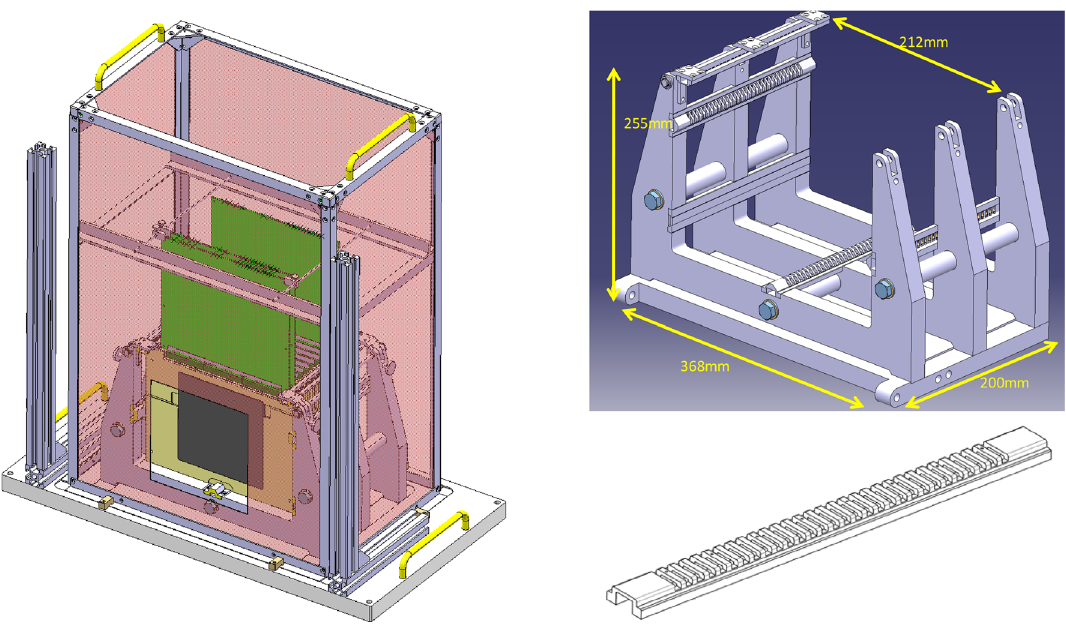
Fig. 2 Left-hand side: Scheme of the complete mechanical structure with the tungsten absorbers and readout boards installed. Upper right- hand side: Dimensions of the precision mechanical frame for the posi-